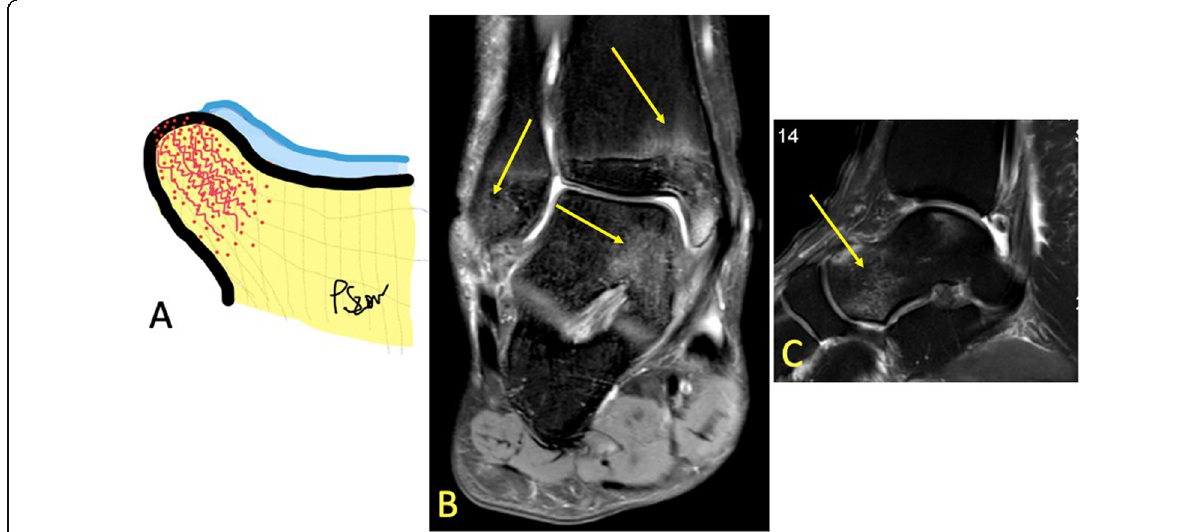
Fig. 2 A 20-year-old soccer player presented after an ankle sprain during a soccer match with suspicion of a fracture in the lateral malleolus. MRI showed bone bruise in the tibia, fibula, and talus (arrows). It revealed no fracture of the lateral